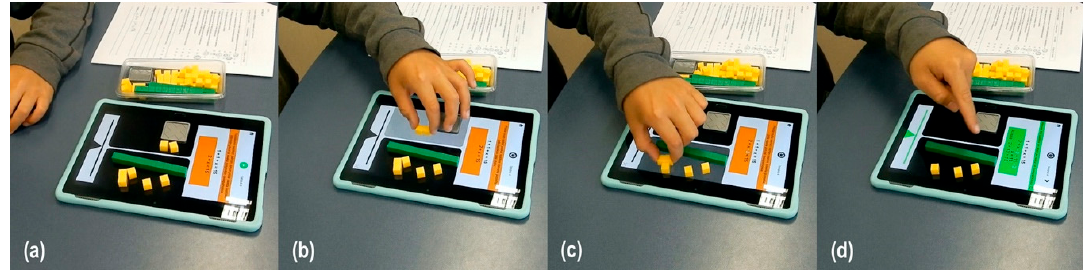
Figure 11. Student solving an equation (1 + 1 + x = 15) at Level 2 (doing the same operation on both sides of an equation). ( a ) Correct modelling of the equation; ( b ) ‘You have to take two away from here, so that x will stay alone’ (taking two base-10 units from the left side of the scale); ( c ) ‘Then you have to take also two from here’ (taking two base-10 units from the right side of the scale). ‘Because if you take [blocks] from one side, then you have to take [blocks] also from the other side’; ( d ) ‘So, here is 13, which is equal to x’ (pointing at the rest of the blocks on the